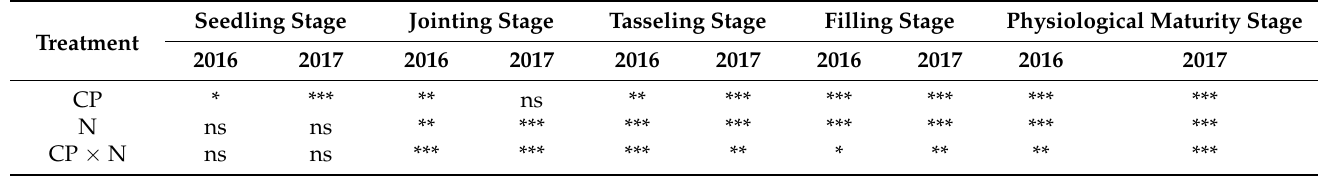
Table 4. Significance of the effects of treatments on dry matter accumulation at various stages of plant development.